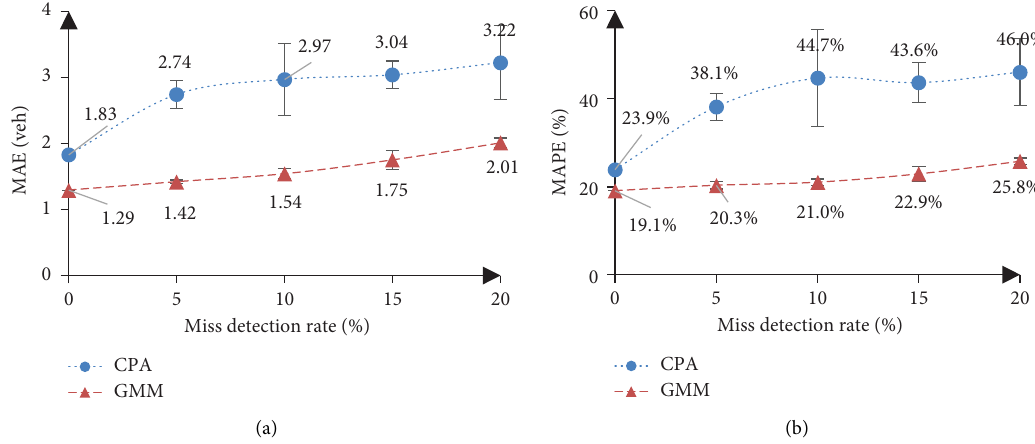
Figure 7: Estimation results under diferent miss detection rates. (a) MAE. (b)